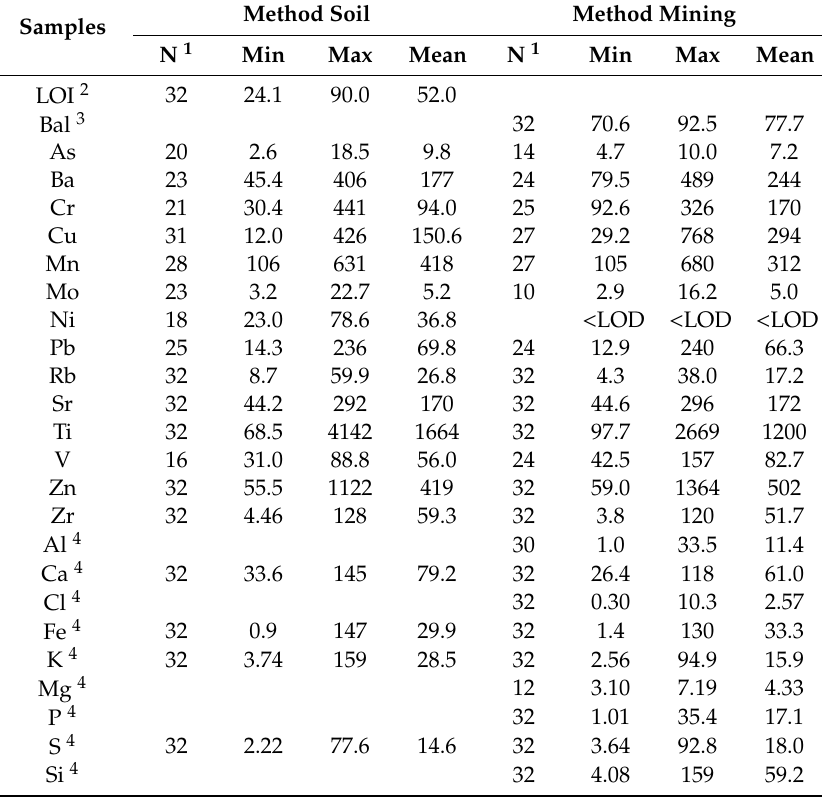
Table 1. Comparison of ranges of elemental concentrations (mg kg − 1 unless otherwise stated) determined using portable X-ray spectrometry